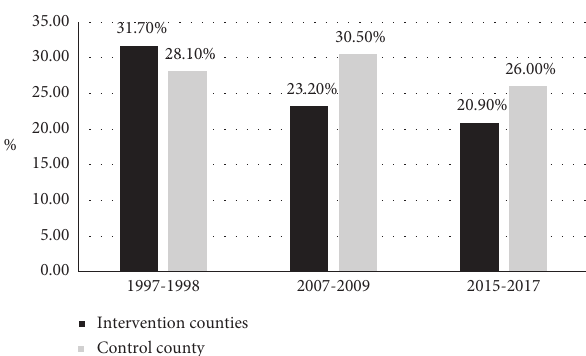
Figure 3: Changes in the proporton of case/NCD death for stroke between 1997 and